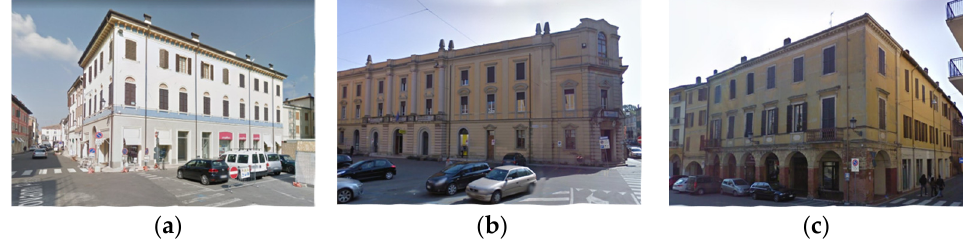
Figure 6. Selected buildings in Mirandola, Italy: ( a ) Building 1, ( b ) Building 2, and ( c ) Building 3; © Google.